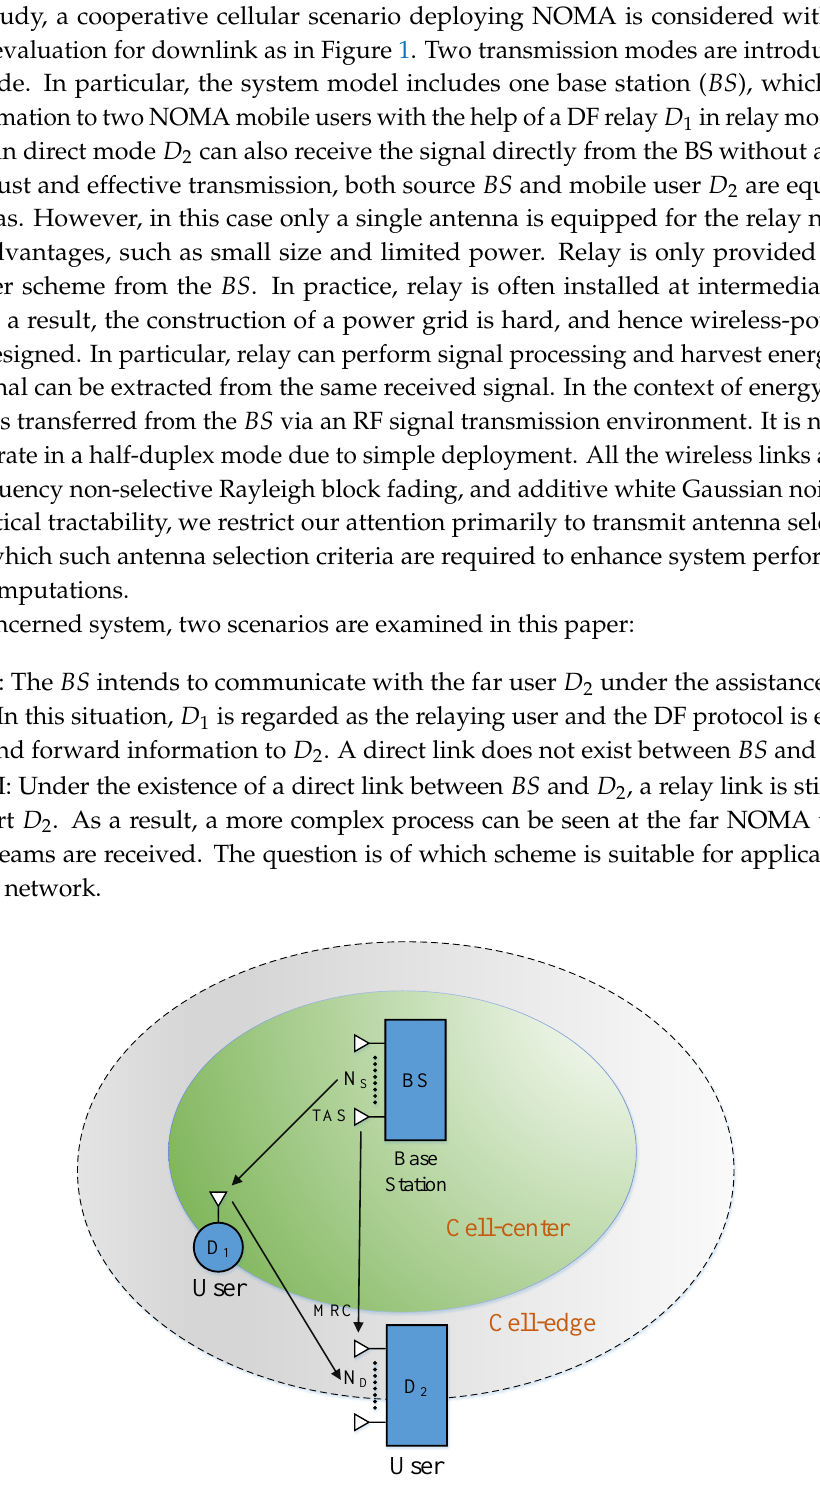
Figure 1. The proposed system model of NOMA facilitating multiple antennas at the BS and cell-edge